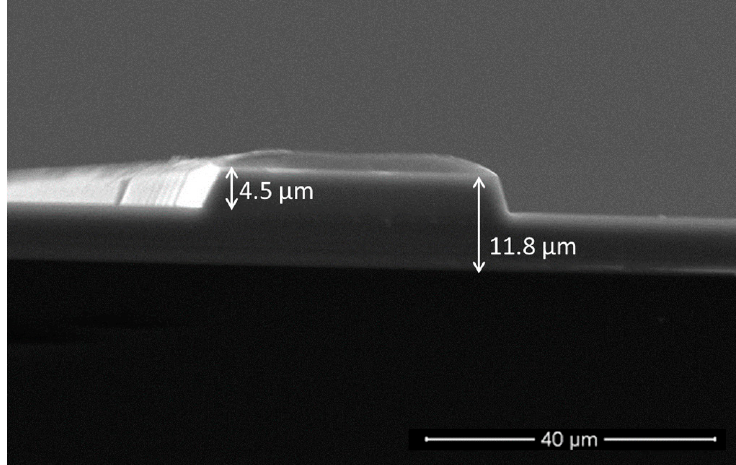
Figure 3. SEM picture of a typical rib waveguide.